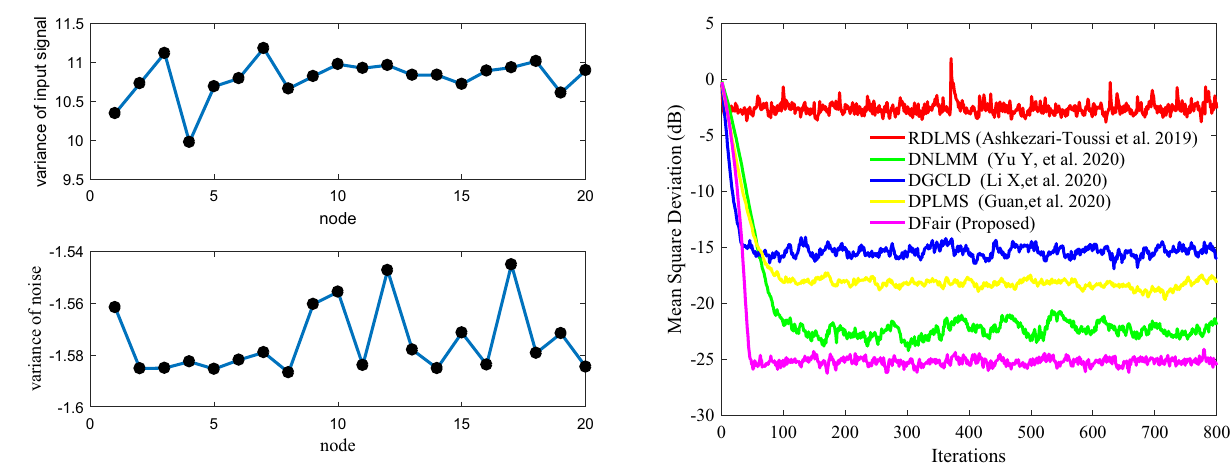
Figure 6. (Left_top) the input signals { X n ( i ) } variances of at each network node with R xx , n is a diagonal matrix with possibly different diagonal entries chosen randomly, (Left_bottom) the measurement interference variances ε n ( i ) at each network node; (Right) Transient network MSD (dB) iteration curves of the RDLMS, DNLMM, DGCLD, DPLMS, and DFair